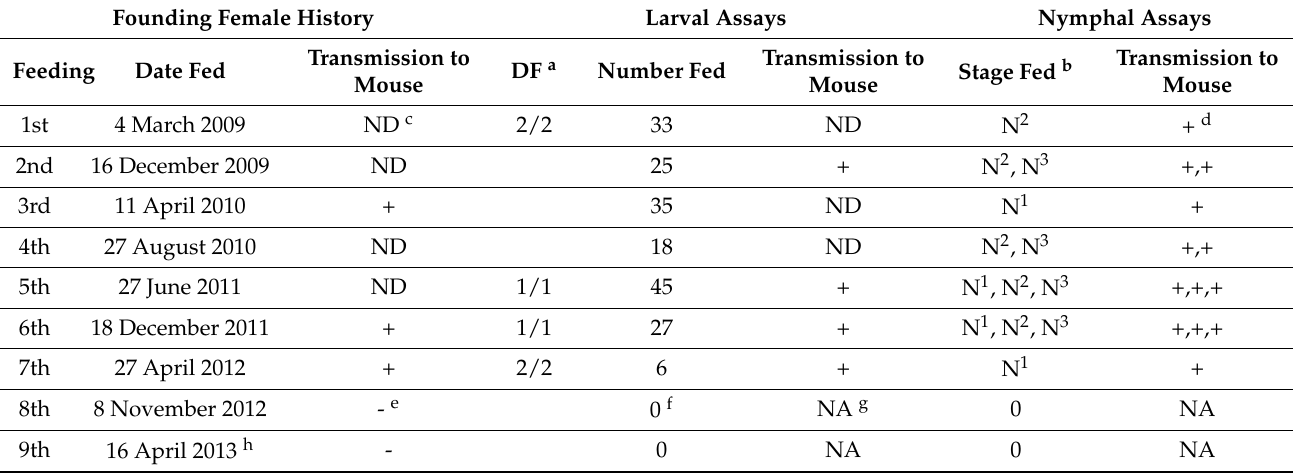
Table 1. Ornithodoros hermsi founding female’s feeding history, oral transmission, and production of infected offspring after each